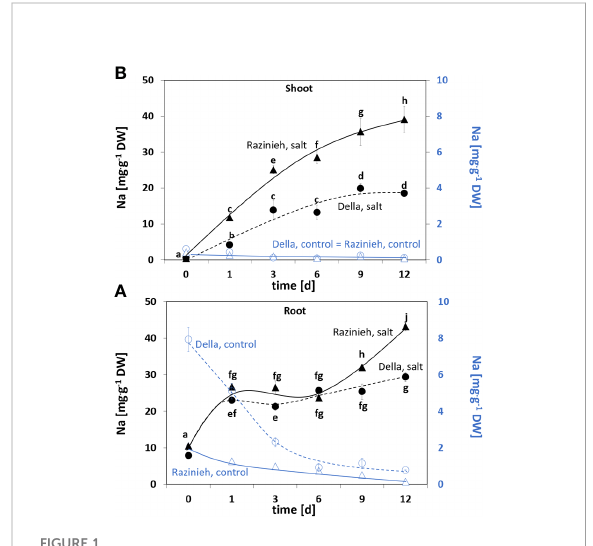
FIGURE 1 Content of sodium ions in (A) roots and (B) shoots of sorghum genotypes Della and Razinieh. Thirteen days old Della (dashed line), and Razinieh (solid line) seedlings were stressed in aqueous NaCl (100 mM) solution for 1, 3, 6, 9, and 12 days. Values represent the mean of at least three independent biological replicates ± SE. Different letters show signi fi cant differences between different genotypes and treatments according to Duncan ’ s test ( P <